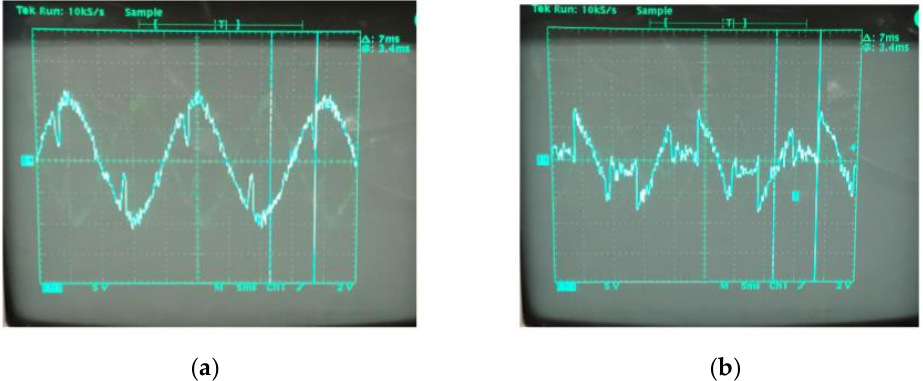
Figure 10. The output signal from Kemos just before its entrance to the motor that: ( a ) rotates faster, if the sinusoid signal is slightly modified; ( b ) or rotates slower, if the signal is heavily modified.